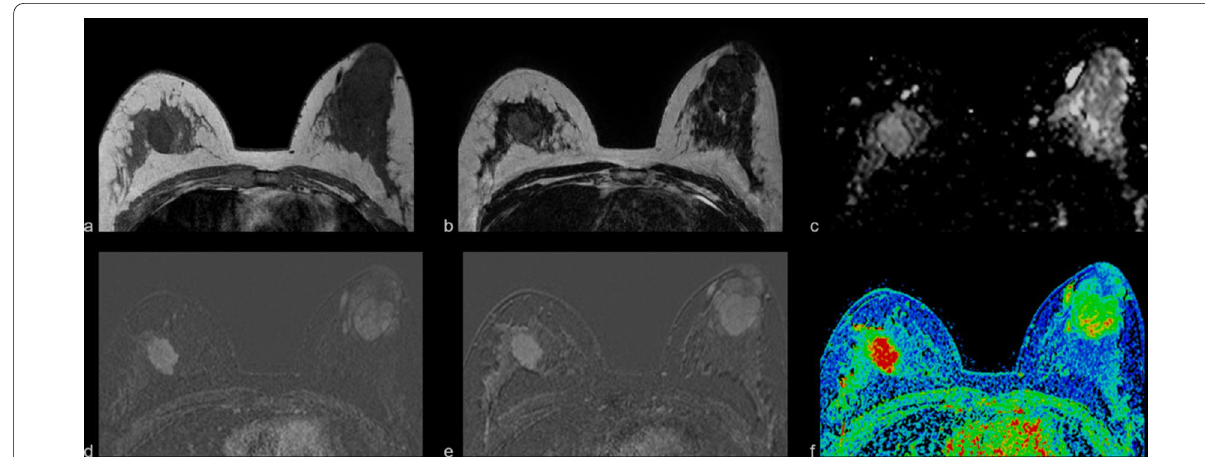
Fig. 7 Example of MRI finding of breast lesion classified as BIRADS 4A by echography. A 26‑years‑old patient with a giant fibroadenoma at the left breast without suspicious contrast enhancement and size stability compared to previous ultrasound studies. At the right breast, a mass with lobulated contours, hypointense on the T1W sequence ( a ), which shows hyperintensity to the glandular parenchyma on the T2 sequence ( b ), and an ADC ( c ) of 1.8 10 − 3 mm 2 /s. Postcontrast subtraction images show a contrast enhancement that describes an ascending and plateau × uptake from initial ( d ) to delayed ( e ) subtractions, with rapid enhancement ( f ). It presented characteristics of fibroadenoma; however, as it has shown a size increase compared to previous ultrasonography studies, histological analysis was required, resulting in a pericanalicular fibroadenoma